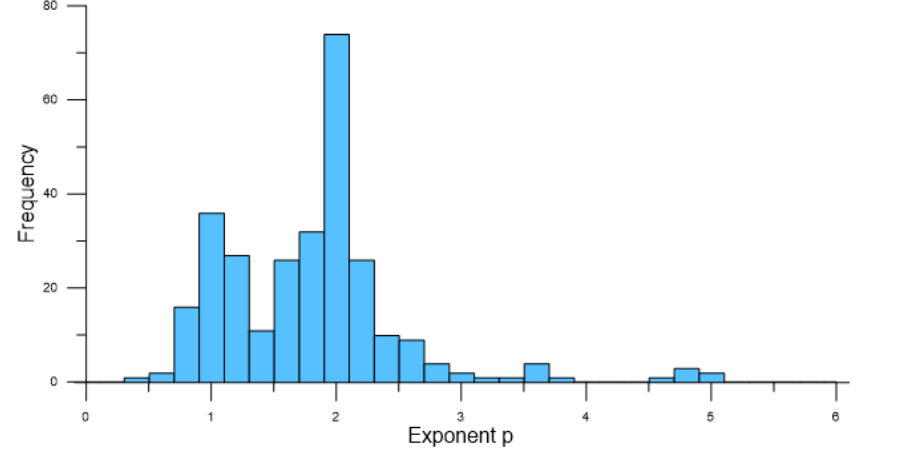
Table 1. Statistics of the parameter p.